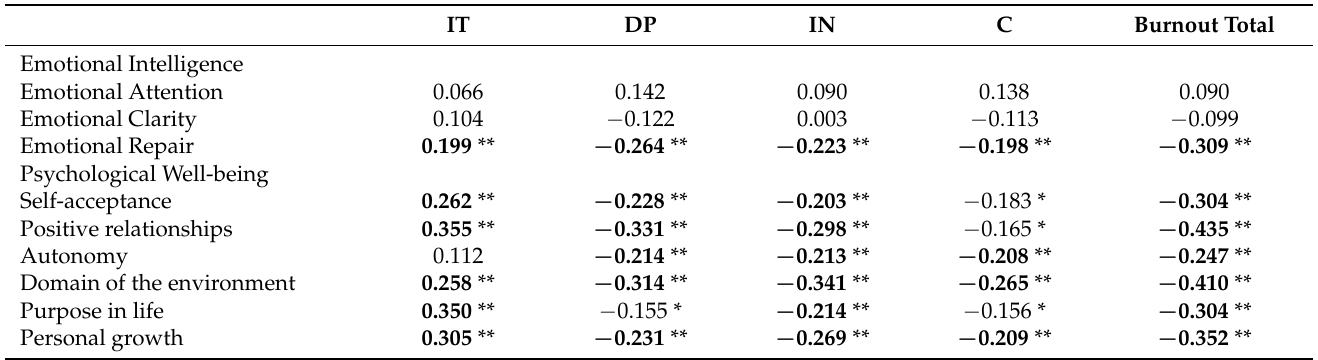
Table 2. Relationship between emotional intelligence and psychological well-being and burnout in teachers-in-training.